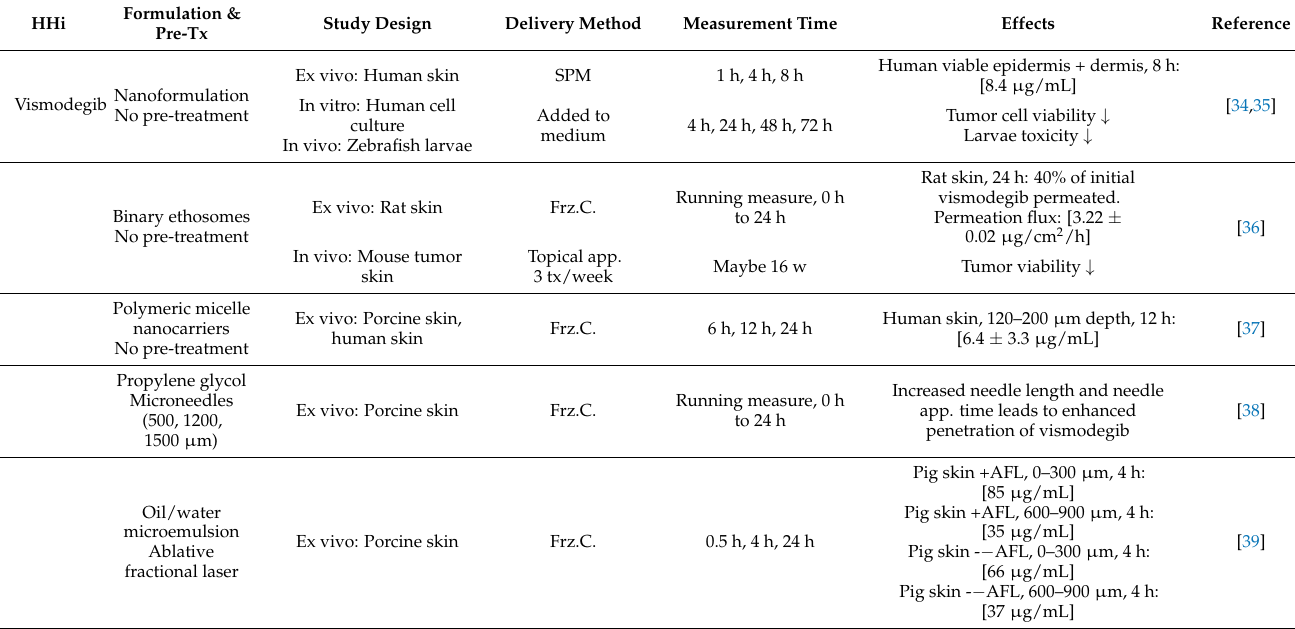
Table 3. Overview of included preclinical